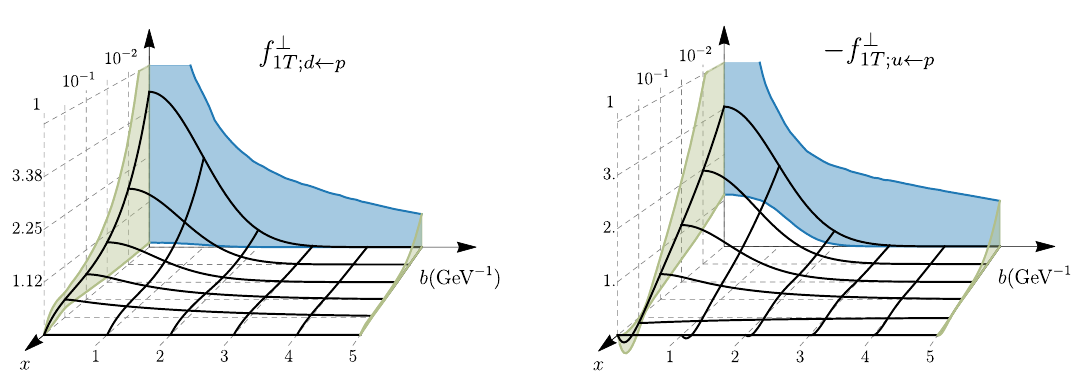
( x, b ) for d -quark (the left panel) 1 T